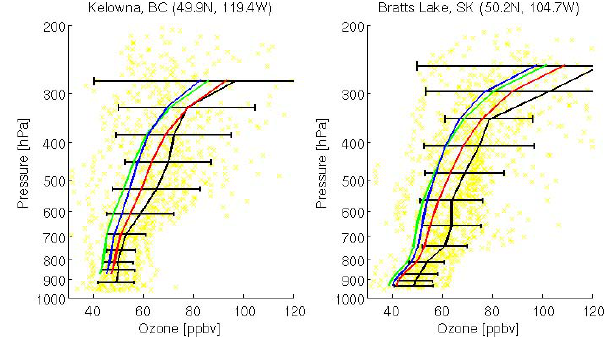
Fig. 8. Mean vertical profiles of ozone in the troposphere from ozonesondes at Kelowna, BC (left) and Bratt’s Lake, SK (right). Yellow crosses represent sonde data. Black lines represent the mean and standard deviation of the measurements. Red lines repre- sent campaign average profiles from the baseline simulation; green, from the “no Asia” simulation; and, blue, from the “no lightning” simulation. Measurements are filtered for stratospheric influence (ozone >